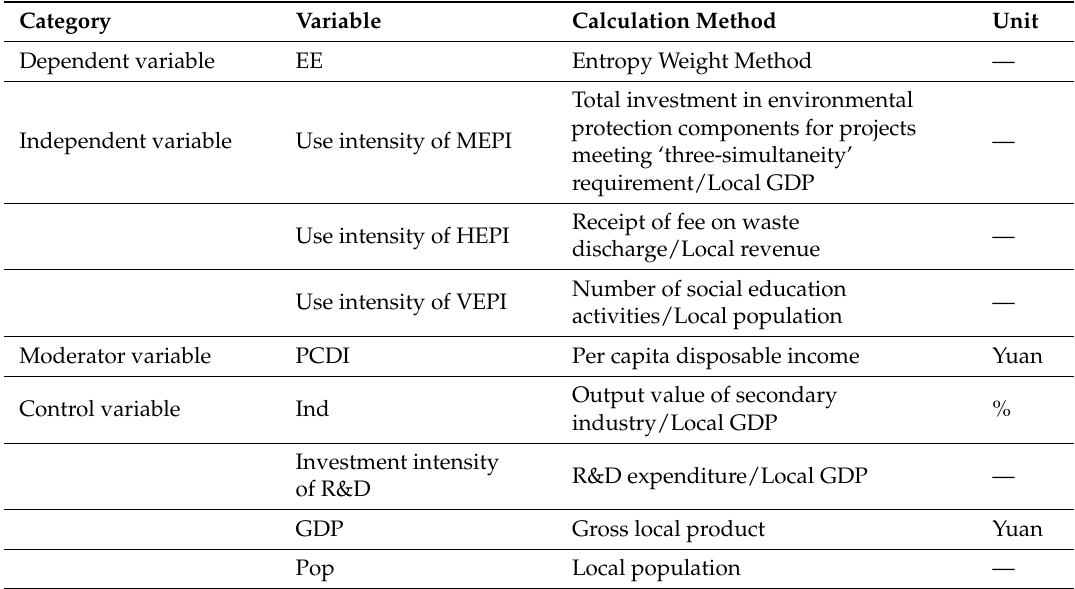
Table 3. The calculation method of the